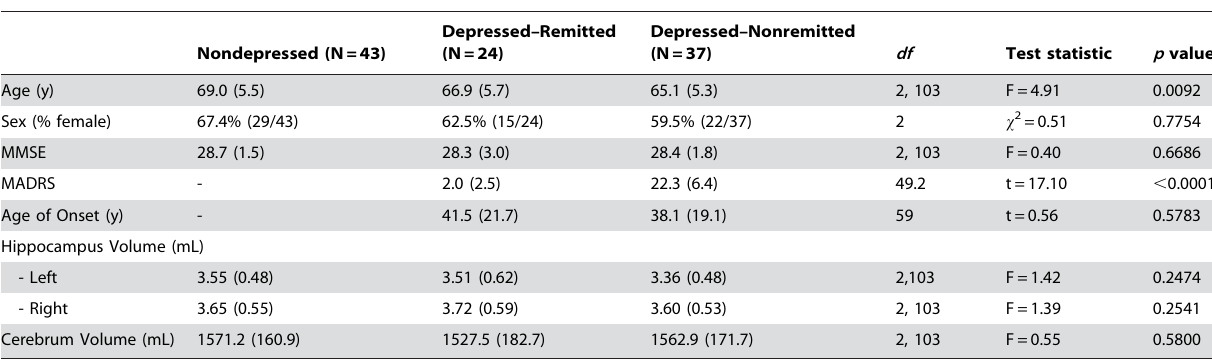
Table 1. Group differences based on diagnosis and remission status